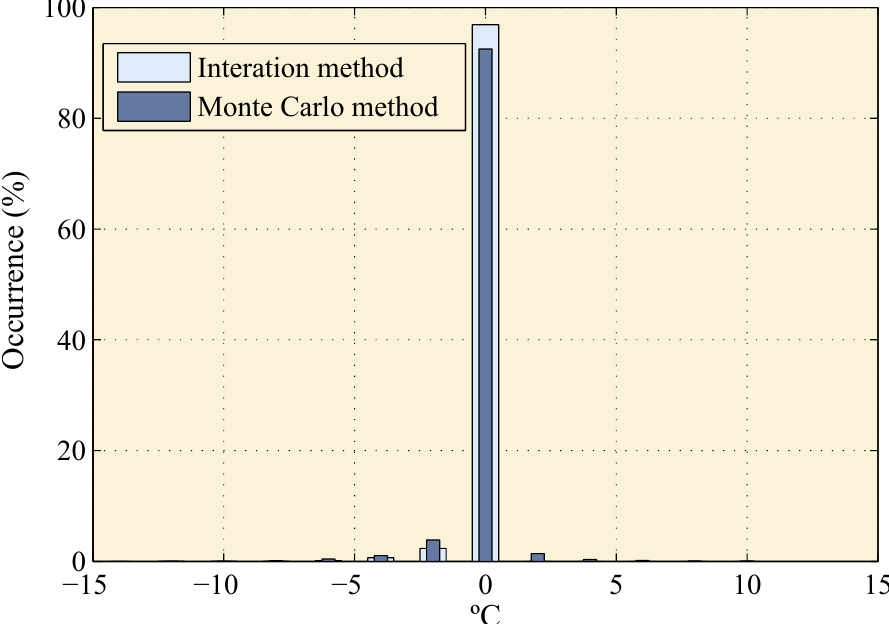
Figure 16. Differences between measured and effective perpendicular wind speed. Regarding to ambient temperature, it is obtained similar data to wind, as shown in Figure 17. Approximately 90% of the cases have differences close to 0 °C.